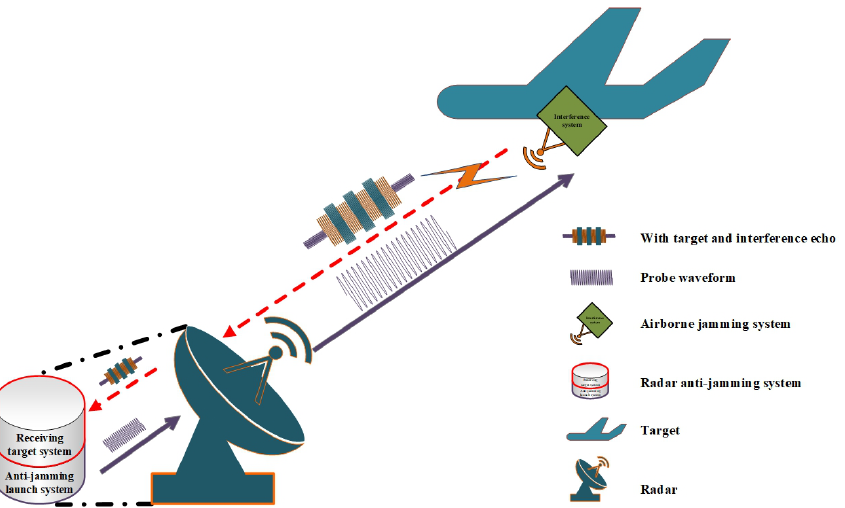
Figure 1. Anti-jamming principle diagram based on frequency agile radar radar and airborne jamming